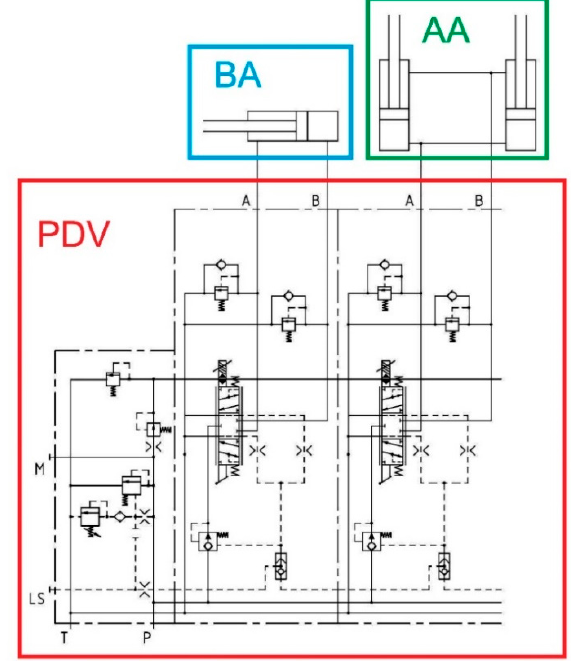
Figure 2. Diagram of boom and arm hydrostatic drive without counterbalance valves, where AA represents the hydraulic cylinders of the arm, BA represents the hydraulic cylinders of the boom, and PDV represents the boom and arm section of the proportional directional valve with “load-sensing” system.